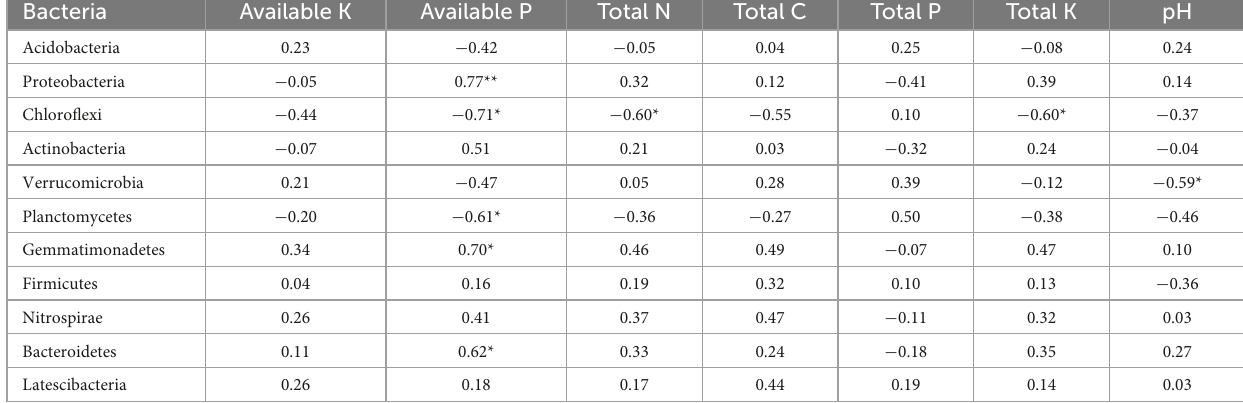
TABLE 6 Correlation between bacterial community structure and soil chemical